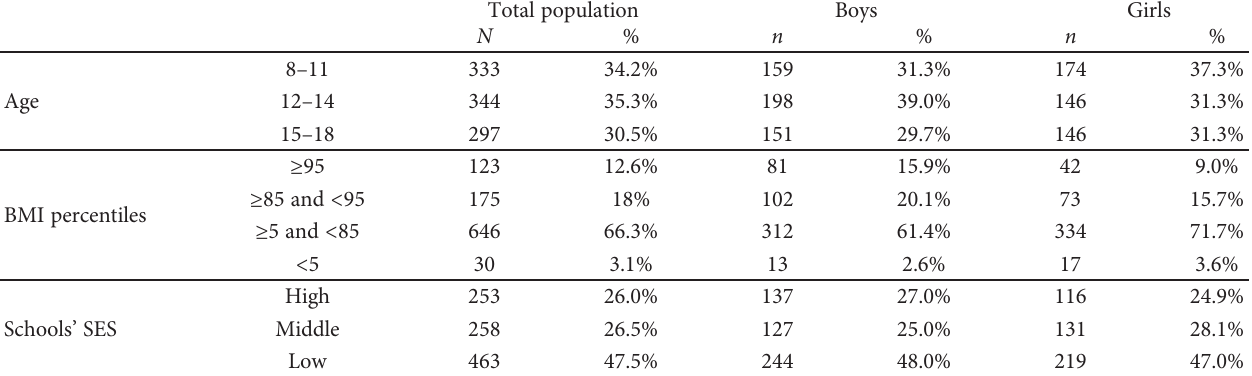
Table 2: Distribution of the population according to age groups, BMI categories, and SES.